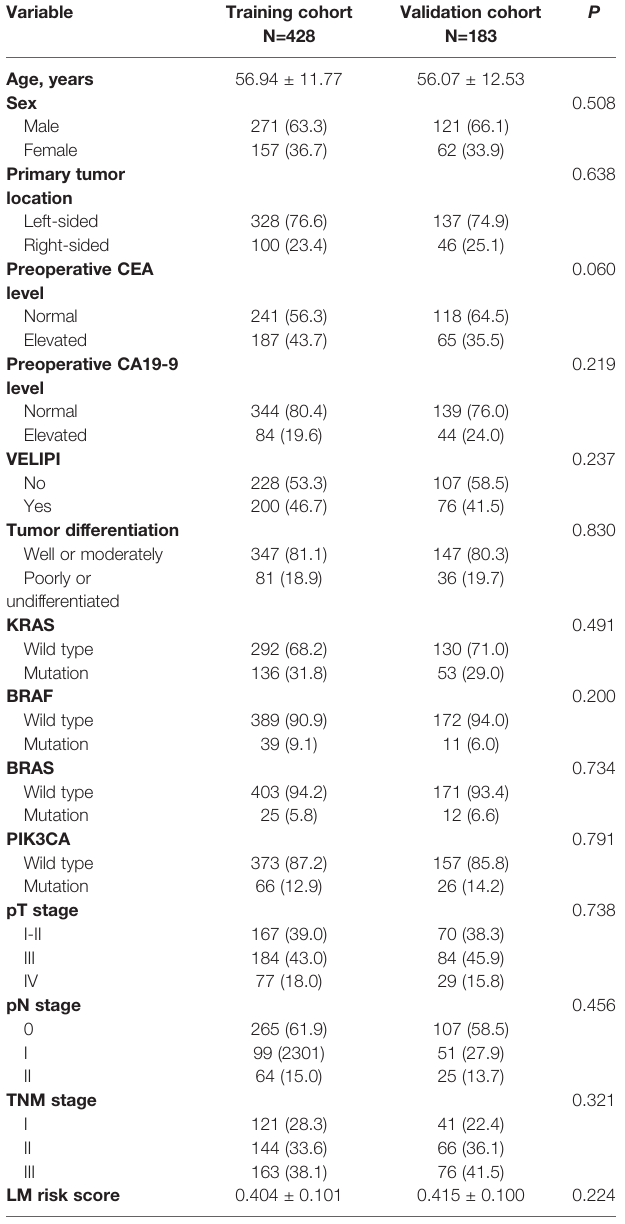
TABLE 1 | Characteristics of the patients in the training and validation